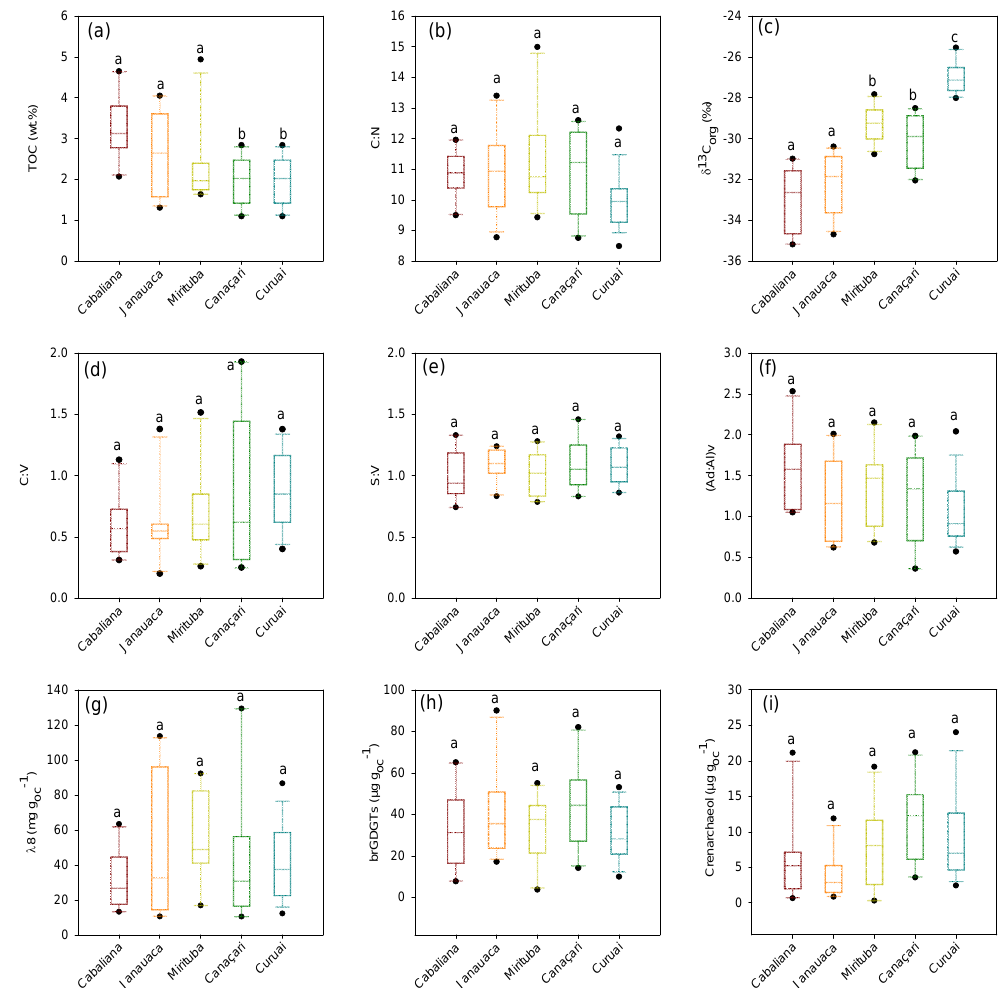
Figure 3. Box plots of bulk OC parameters, lignin phenols, and GDGTs along the upstream–downstream transect. The midpoint of a box plot is the mean. The 25 and 75% quartiles define the hinges (end of the boxes), and the difference between the hinges is the spread. Letters indicate statistically significant groups of data ( p